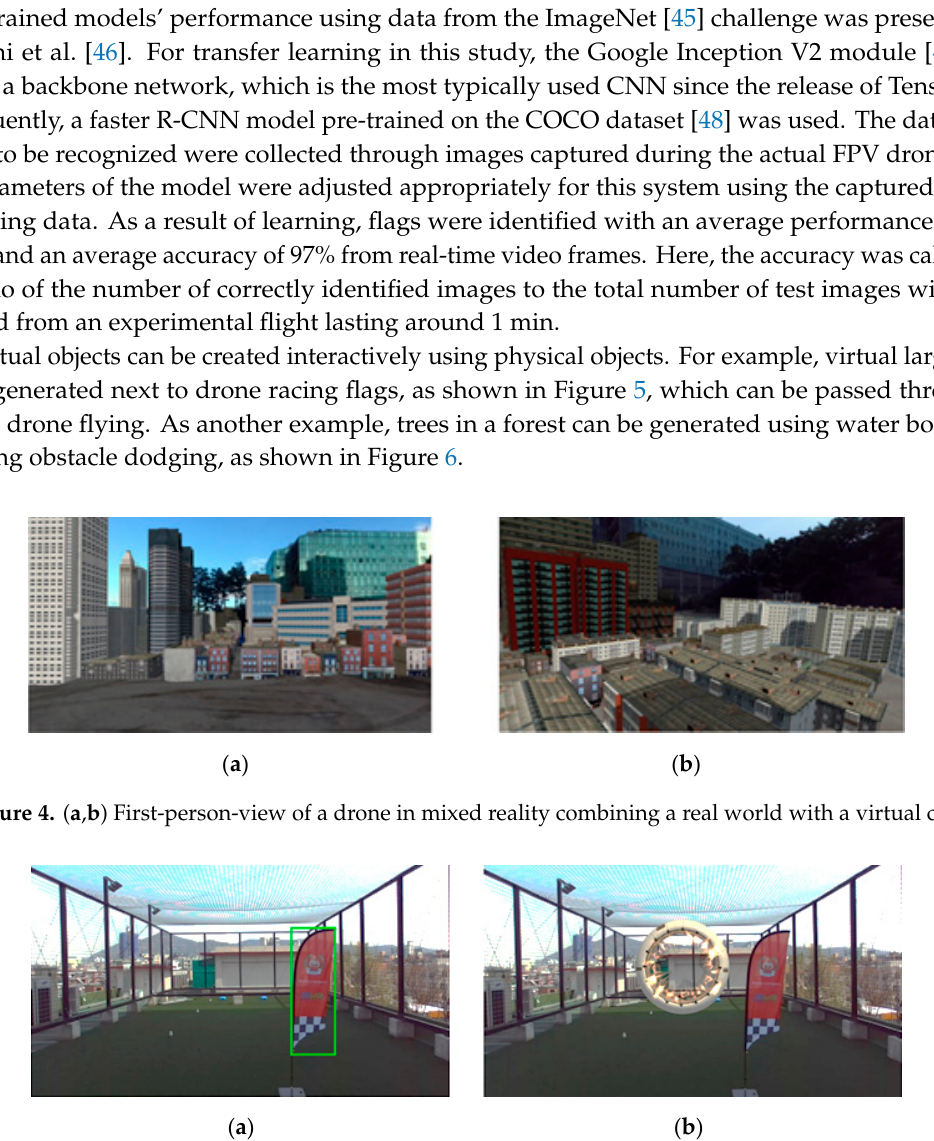
Figure 4. ( a , b ) First-person-view of a drone in mixed reality combining a real world with a virtual city.